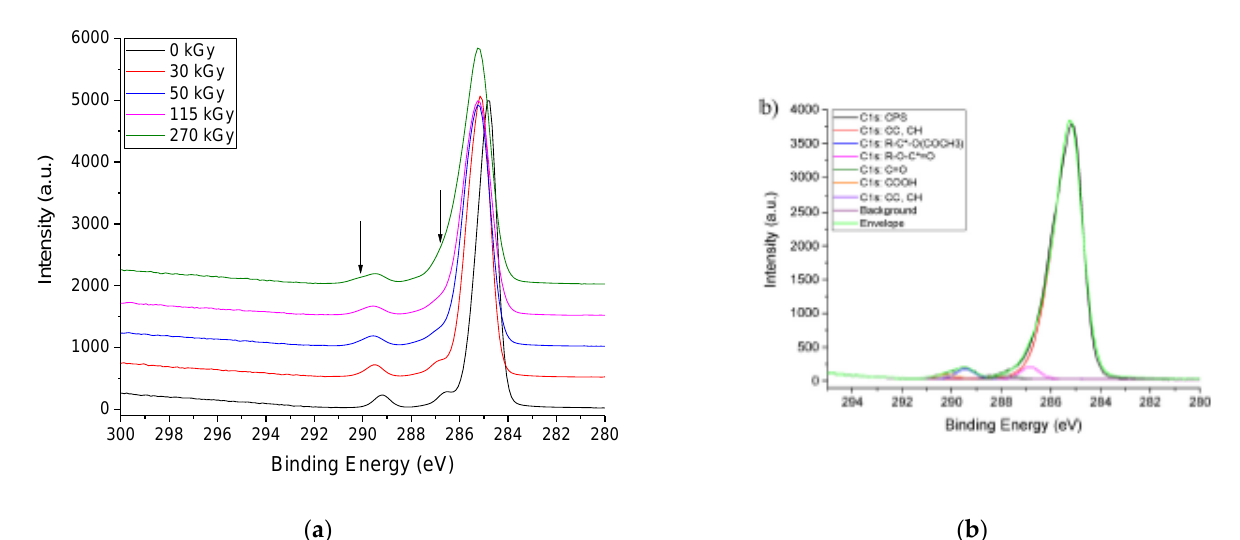
( d ) Figure 9 . PCA of EVA spectra at all γ-irradiation doses (1760–1670 cm −1 // 1280–1180 cm −1 ). Spectra are baseline corrected and normalized. ( a ) Score plot of PCA with γ-dose labels. Dashed line delimits the ageing groups and dotted line delimits the γ-doses groups. ( b ) Score plot of PCA with time labels. ( c ) Loading plot of PC1. ( d ) Loading plot of PC2. Reproduced from [28] with the permission of Polymer Degradation and Stability. 4.2. XPS Analysis The formation of the carbonylated compounds (carboxylic acids, ketones, aldehydes)